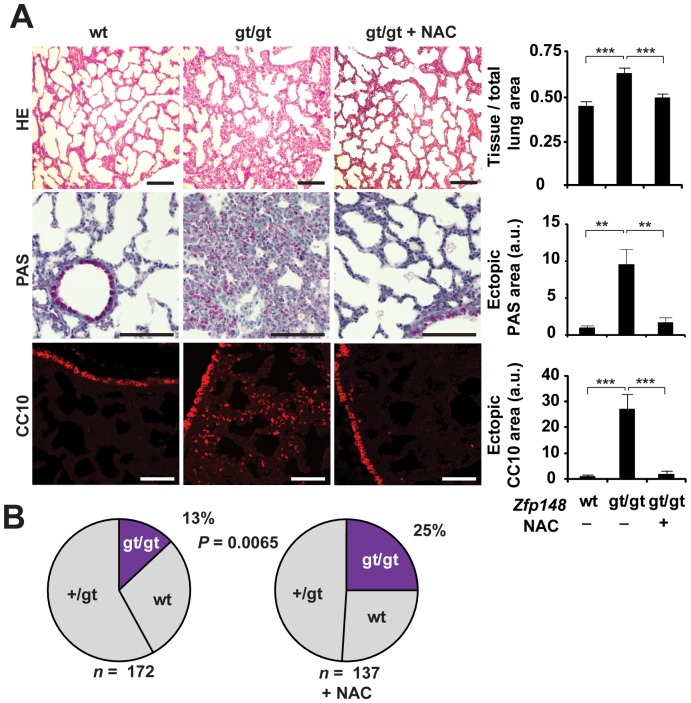
Antioxidant rescue of defect lung maturation and neonatal lethality in Zfp148gt/gt mice.(A) Photomicrographs showing lung morphology (hematoxylin and eosin; HE) and glycogen content (periodic acid-Shiff; PAS) and CC10 immunofluorescence in P1 lungs from Zfp148+/+, Zfp148gt/gt, and NAC treated Zfp148gt/gt mice, respectively (n = 6). Graphs show quantification of mean tissue area per total lung area, PAS-positive area with bronchioles excluded, and CC10-positive area with bronchioles excluded. (B) Distribution of Zfp148 genotypes of P1 pups of intercrosses between Zfp148+/gt mice with and without NAC treatment. Scale bars, 100 µm. **P<0.01, ***P<0.001.